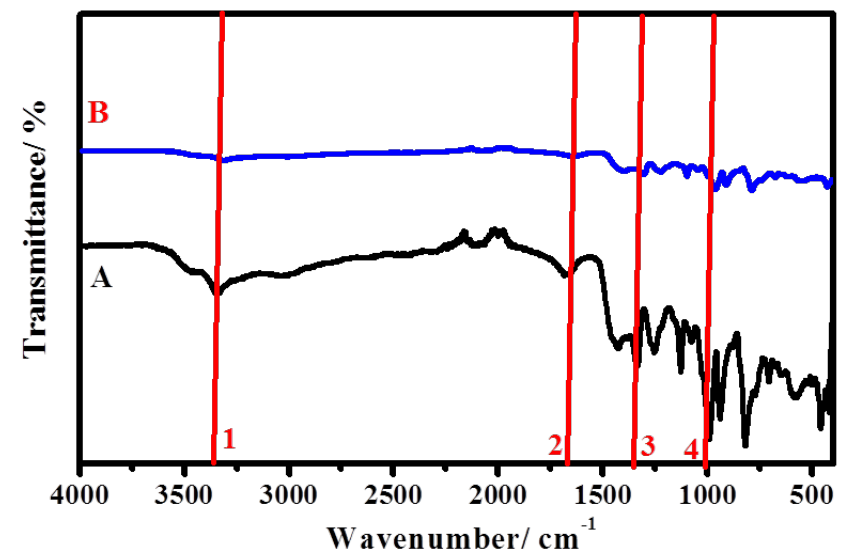
Figure 12. FT-IR spectra of ( A ) crude PAC/NiONPs inhibitor, ( B ) adsorbed film formed on the C-steel surface after dipping in 1.0 M HCl containing 250 ppm PAC/NiONPs .